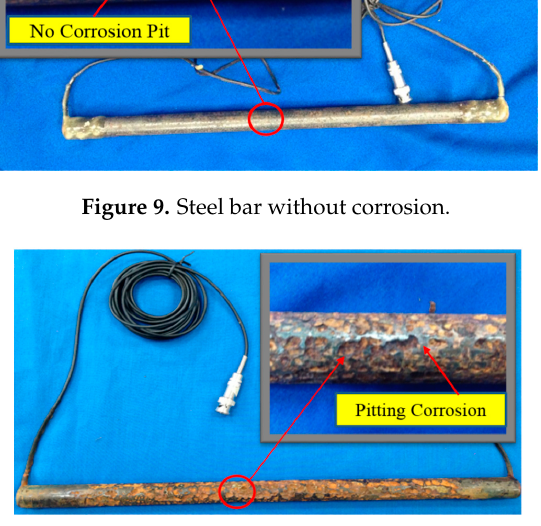
Figure 10. Corrosion of steel bar after 35 h.